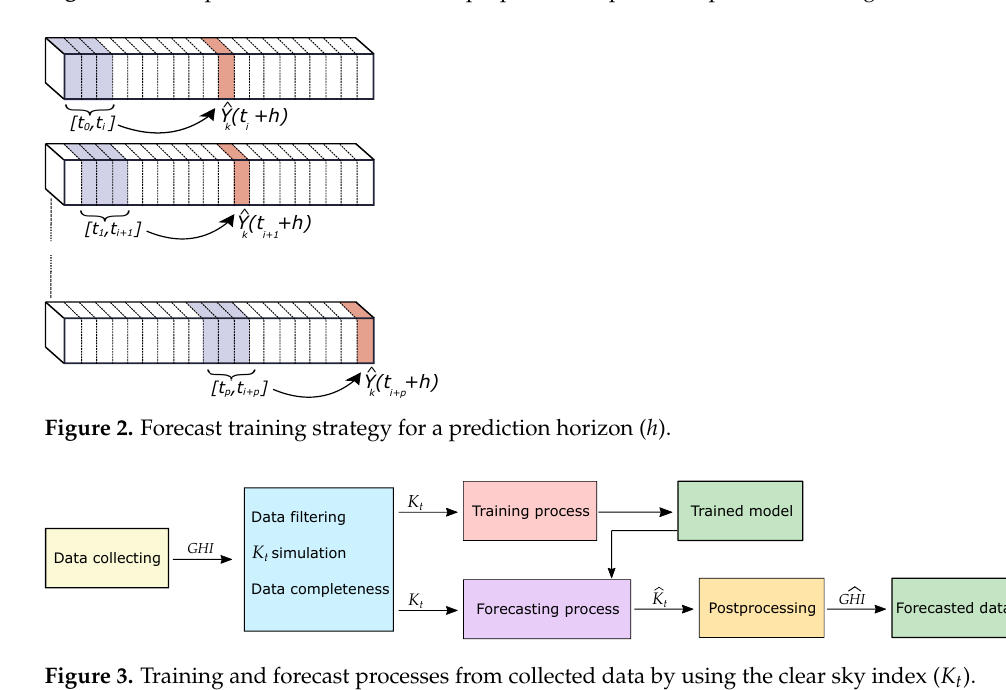
Figure 3. Training and forecast processes from collected data by using the clear sky index ( K t